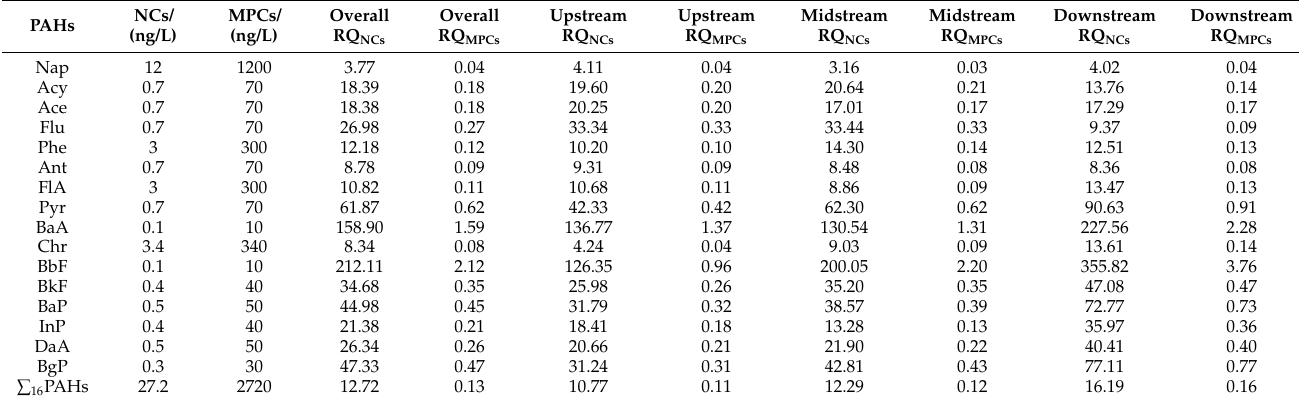
Table 5. RQ NCs and RQ MPCs in groundwater from different